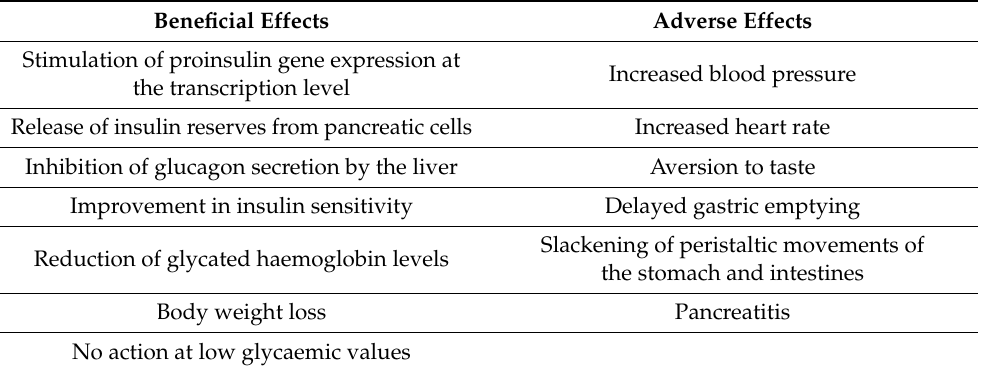
Table 2. Beneficial and adverse effects of Ex-4 in